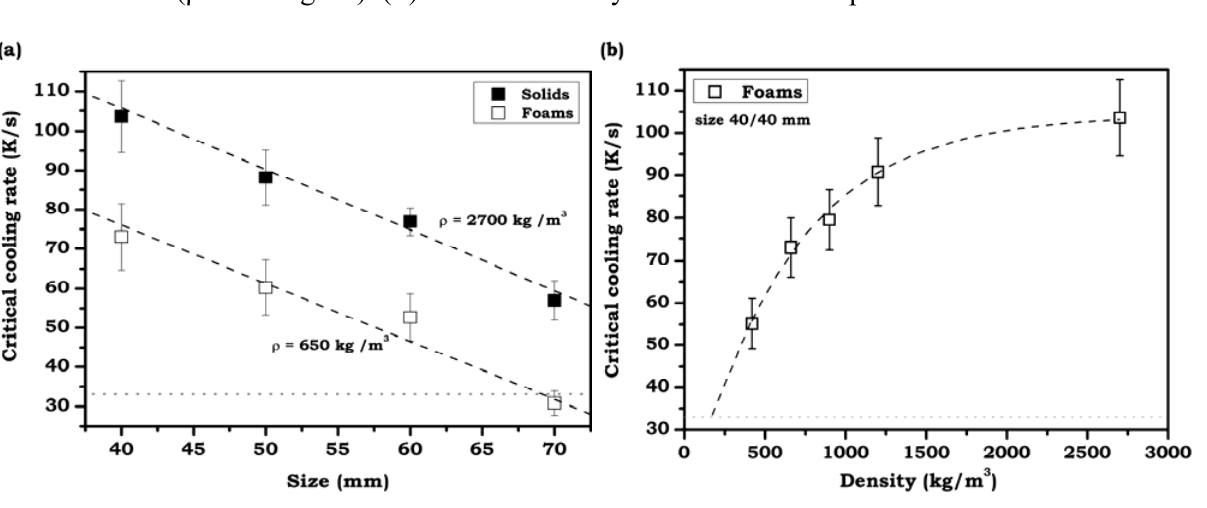
Figure 8. Average cooling rate during the critical range: ( a ) Effect of size on solid samples and foams ( ρ = 650 kg/m 3 ). ( b ) Effect of density on 40/40 mm